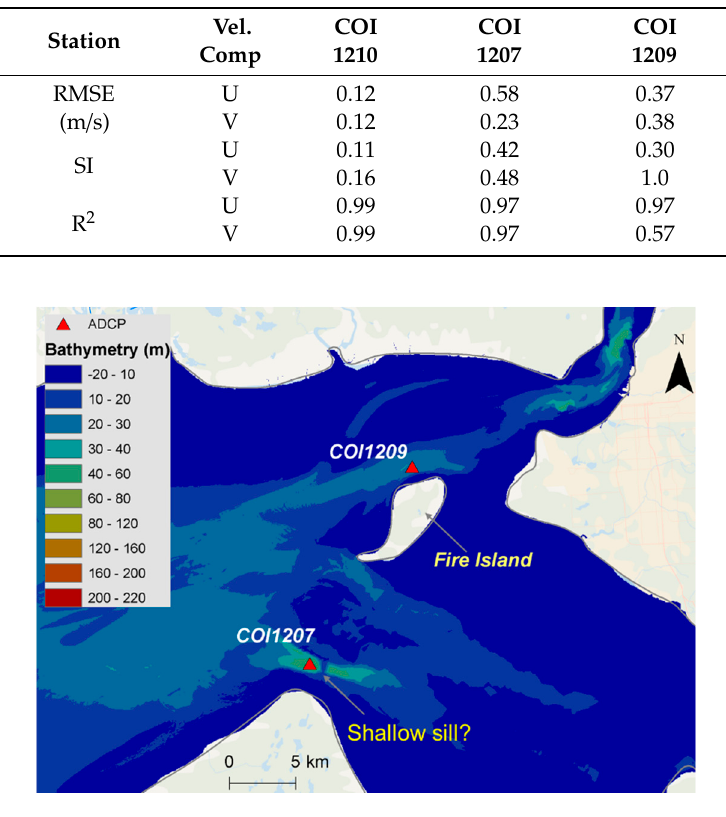
Figure 7. The bathymetric feature near ADCP Stations COI1207 and COI1209 in upper Cook Inlet. The location of a shallow sill near Station COI1207 is pointed by an arrow.